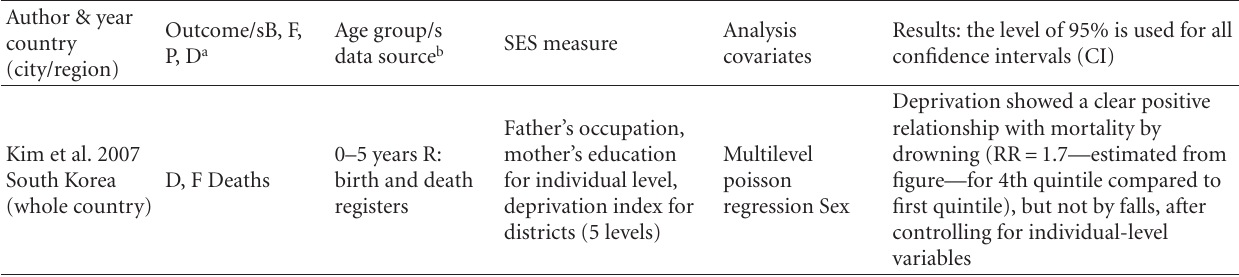
Table 7: Multilevel studies for childhood burn, fall, poisoning, and drowning injuries: summary of methodological features and results ( n =